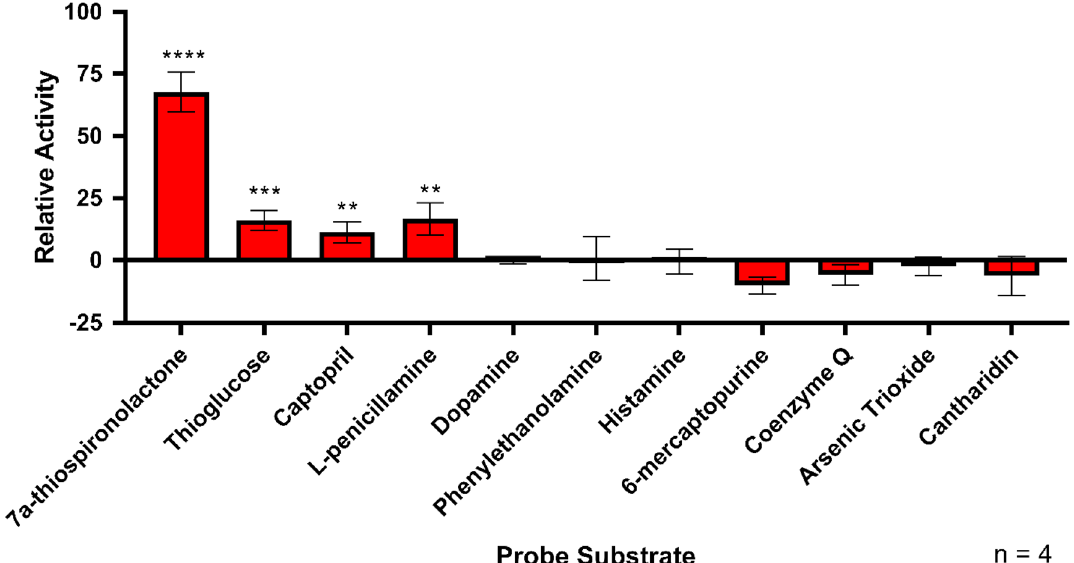
Figure 7. Semi-quantitative screening of select small molecule methyltransferase probe substrates. Multiple methyltransferase probe substrates were incubated for 1 h with His-GST-METTL7B. Formation of AdoHcy (indication of methyl transfer) was measured using the Promega MTaseGlo kit. Activity was normalized to dopamine, a catechol O-methyltransferase probe that showed no activity. All data is presented as the mean ± s.d. Significance was determined using unpaired two-tailed t test. **** P < 0.0001. *** P < 0.001. ** P < 0.01.